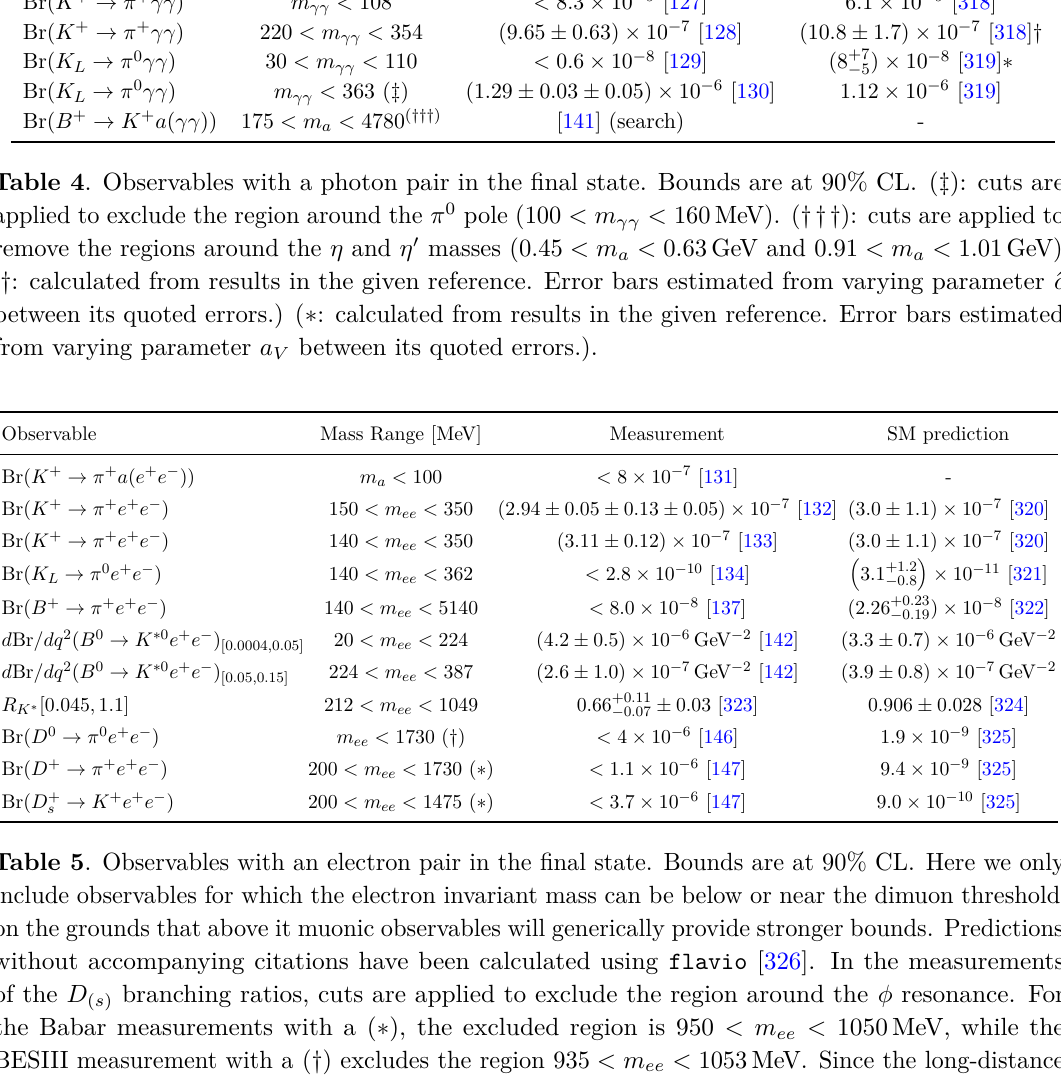
( 100 < m 161 MeV). π X <